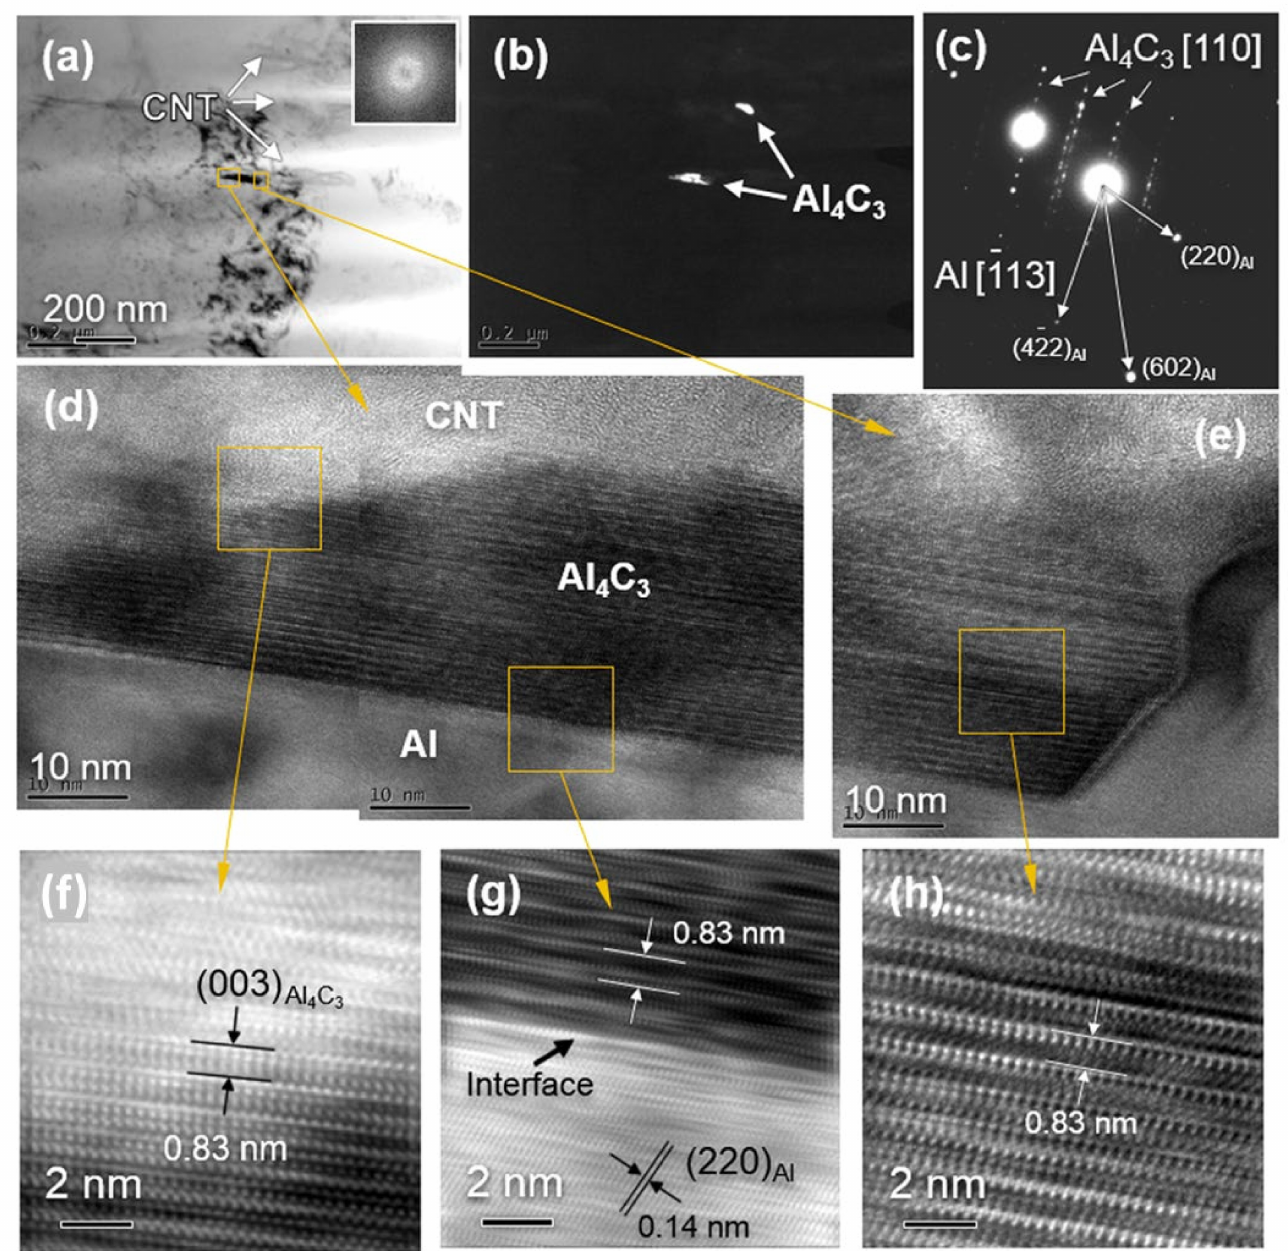
Figure 14. TEM observations of a composite Al/CNT produced at 875 K: ( a ) bright-field image, ( b ) dark-field image corresponding to ( a ); ( c ) selected area electron diffraction (SAED) patterns of ( b ); ( d , e ) high-magnification images and ( f , g , h ) inverse fast Fourier transform (FFT) images. Adapted from [74] with permission from Elsevier,